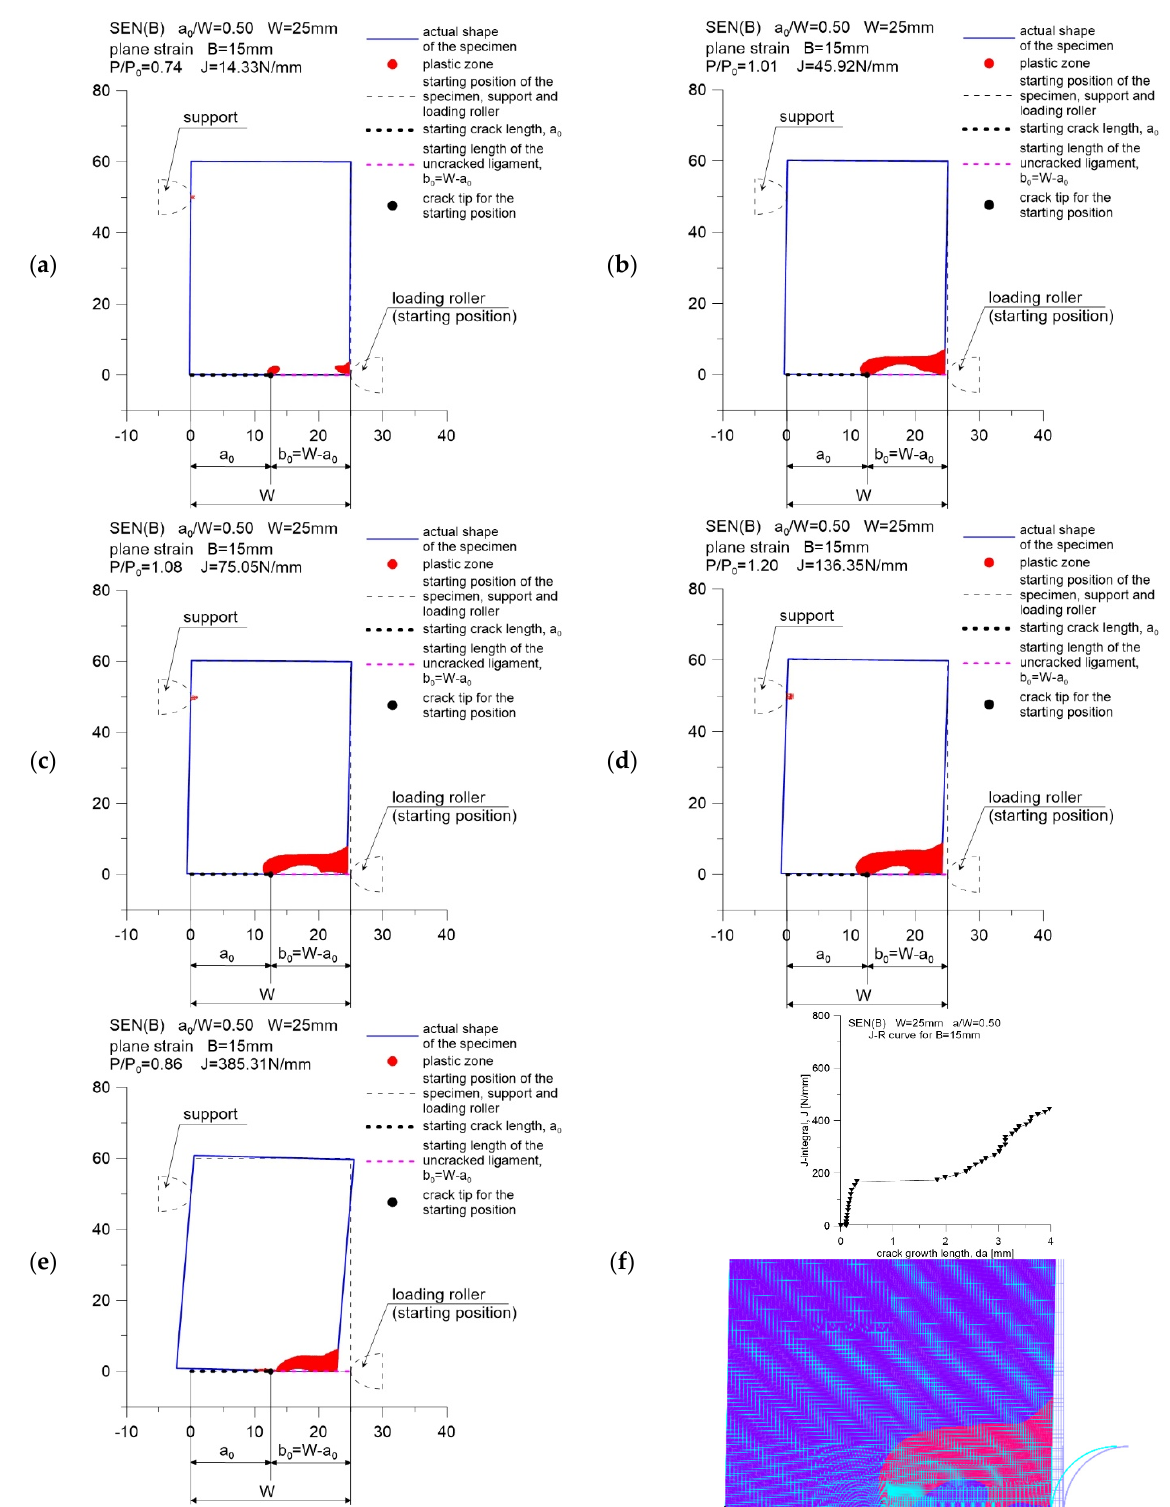
1.34 and J ‐ integral J = 535.980 N/m; ( f ) the J ‐ R curve for specimen and the shape of plastic zone for last point from J ‐ R curve.